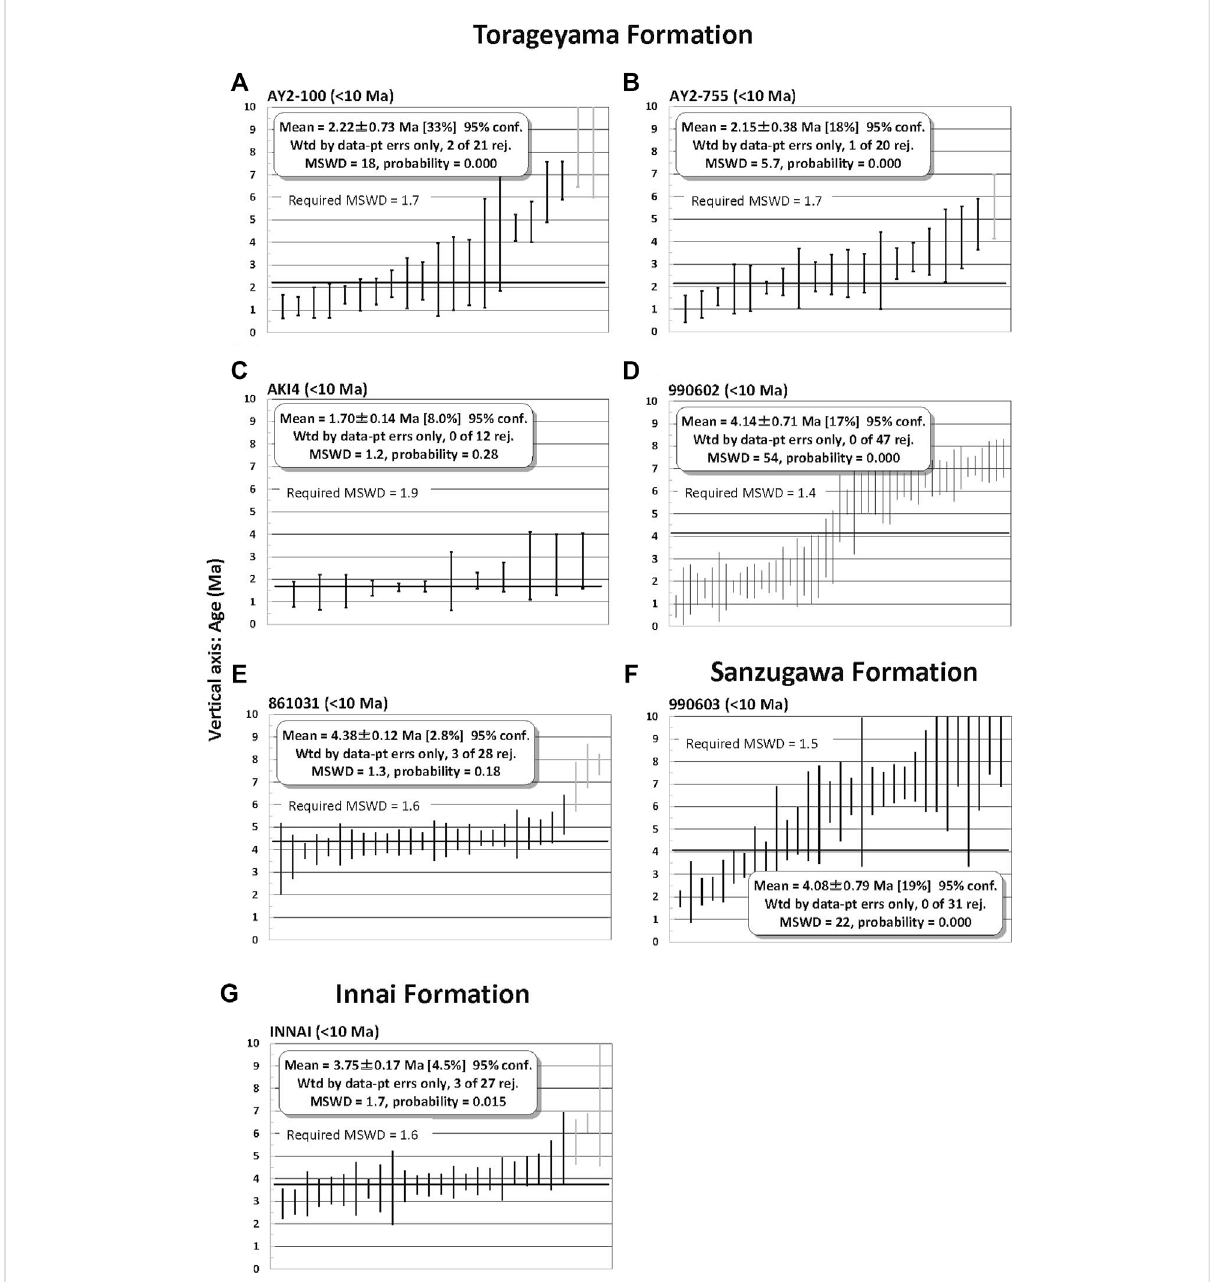
FIGURE 6 238 U- 206 Pb age distributions for zircons younger than 10 Ma. (A – E) Torageyama Formation, (F) Sanzugawa Formation, (G) Innai Formation. Individual grain ages with 2 σ uncertainty are arranged in rank order. Analyses in grey represent statistical outliers and are excluded for weighted mean age calculation.HorizontalbarsrepresentmeanU-Pbages.MSWD:meansquareweighteddeviation. “ RequiredMSWD ” isthelargestMSWDvaluetobea single age population with 95% probability (Wendt and Carl,